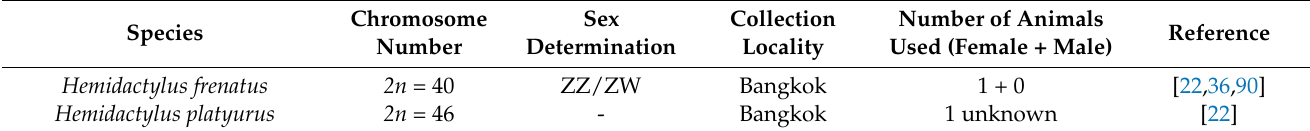
Table 1. List of species, chromosome number, sex determination and collection sites.